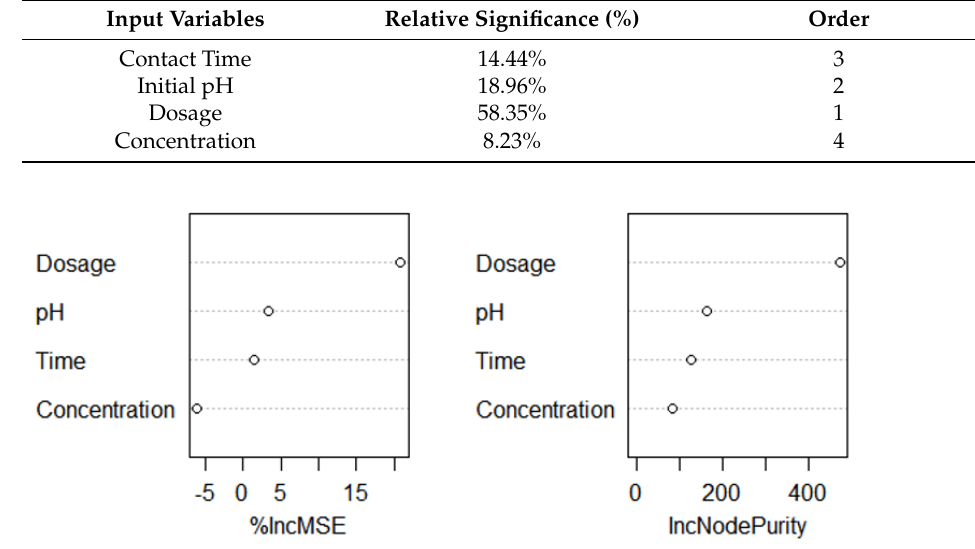
Figure 21. A backpropagation artificial neural network schematic diagram. Table 7. The relative influence of the input variables.